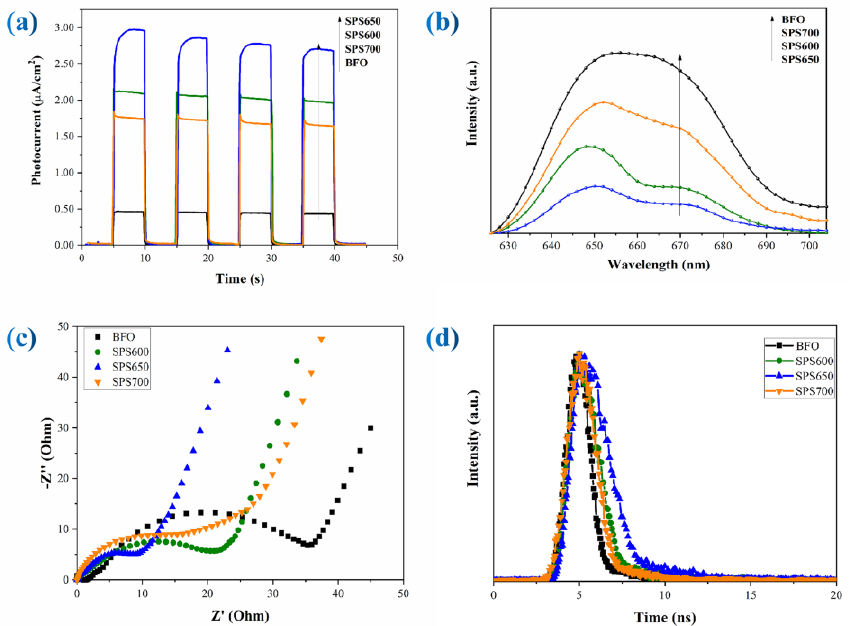
Figure 4. ( a ) The curve of photocurrent density versus time; ( b ) photoluminescence spectrum (PL), ( c ) electrochemical impedance spectroscopy (EIS), ( d ) transient photoluminescence spectrum (TRPL).